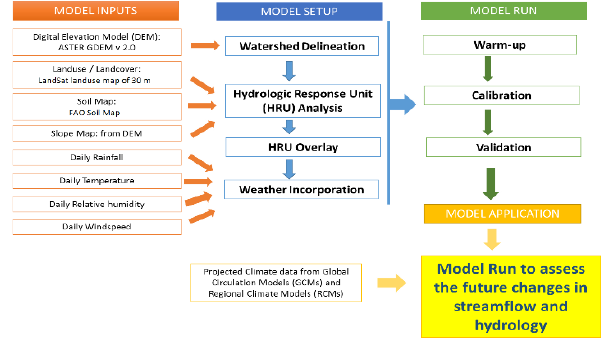
Figure 2. Flow diagram of the